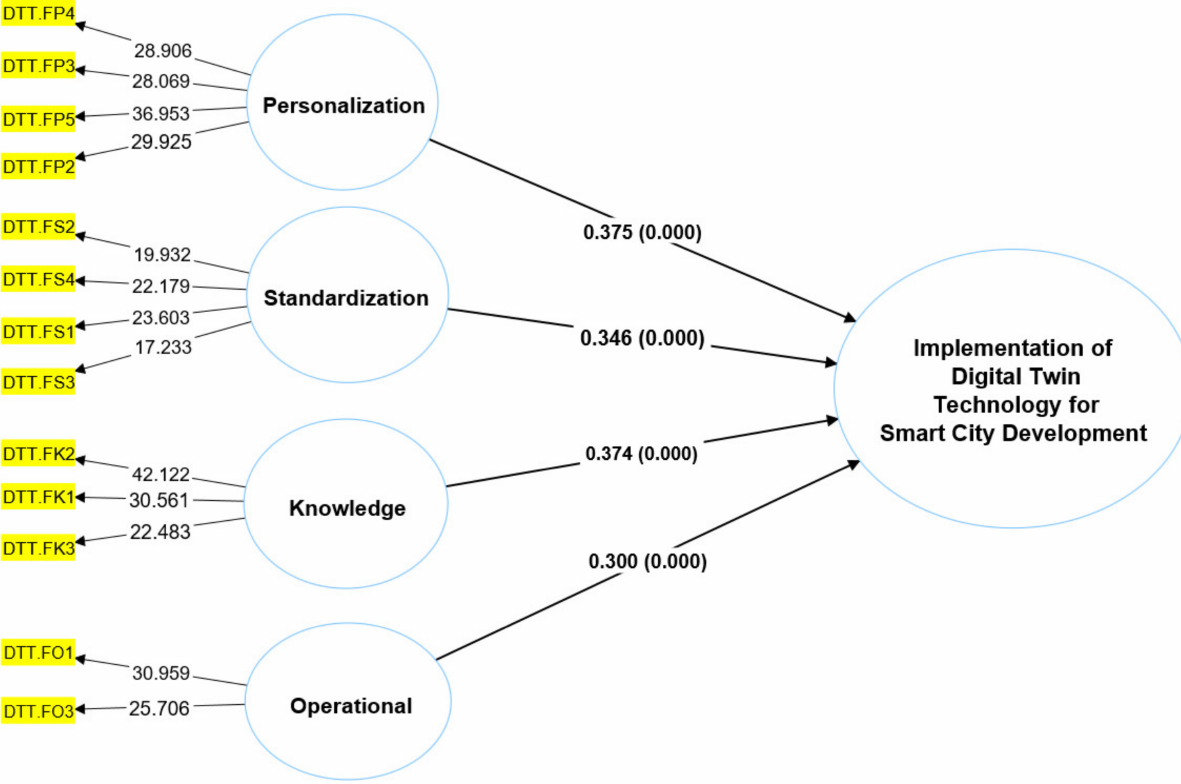
Figure 6. Model with loading factors and significance